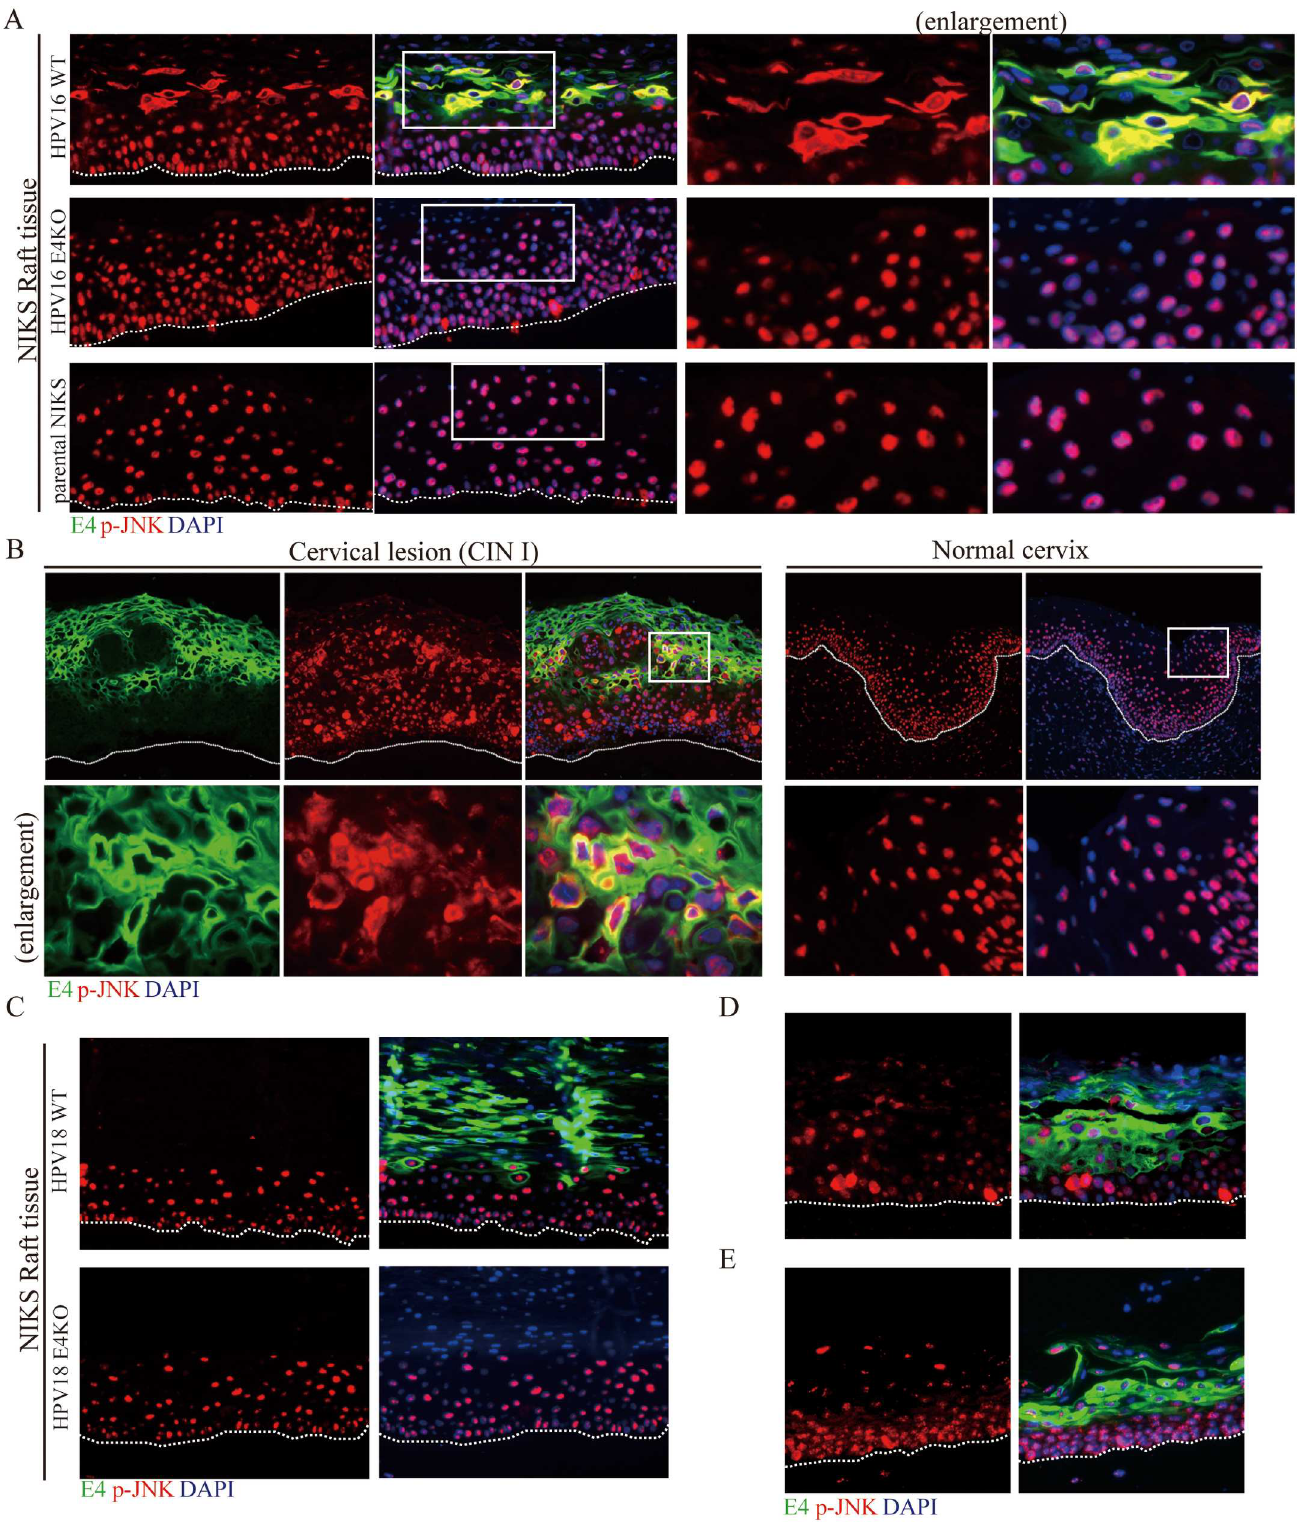
Fig 6. E1^E4 expressionis required for the maintenance of activatedpJNK in the cytoplasm during the late stages of the HPV16 life cycle. (A) Raft tissues derived from NIKS cells or NIKS cells harboringHPV16 WT or E4KO genomeswere analyzedat day 14 post-differentiationafter